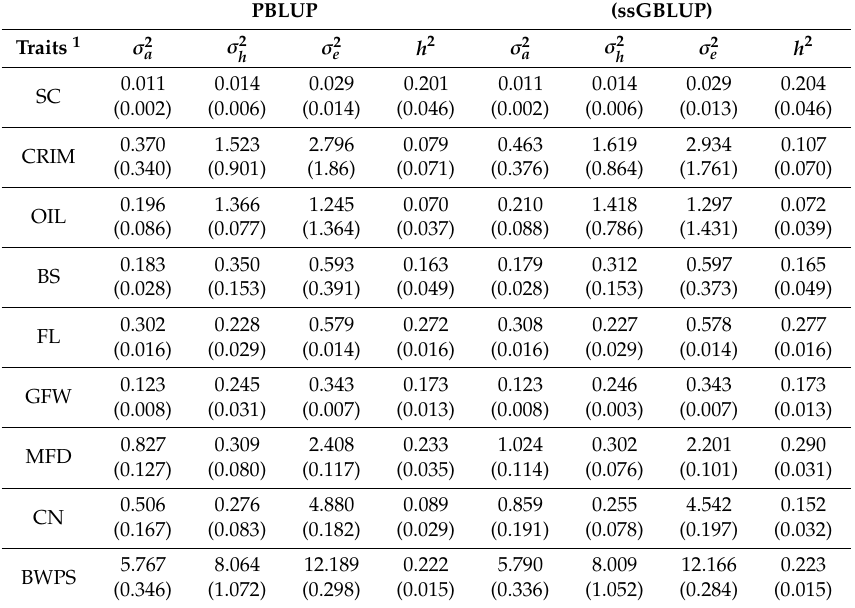
Table 3. Variance components and heritability of wool traits obtained using the pedigree relationship matrix (pedigree-based best linear unbiased prediction (PBLUP)) and combined genomic-pedigree matrix (single-step genomic best linear unbiased prediction (ssGBLUP)) (SE of variance components and heritability reported in